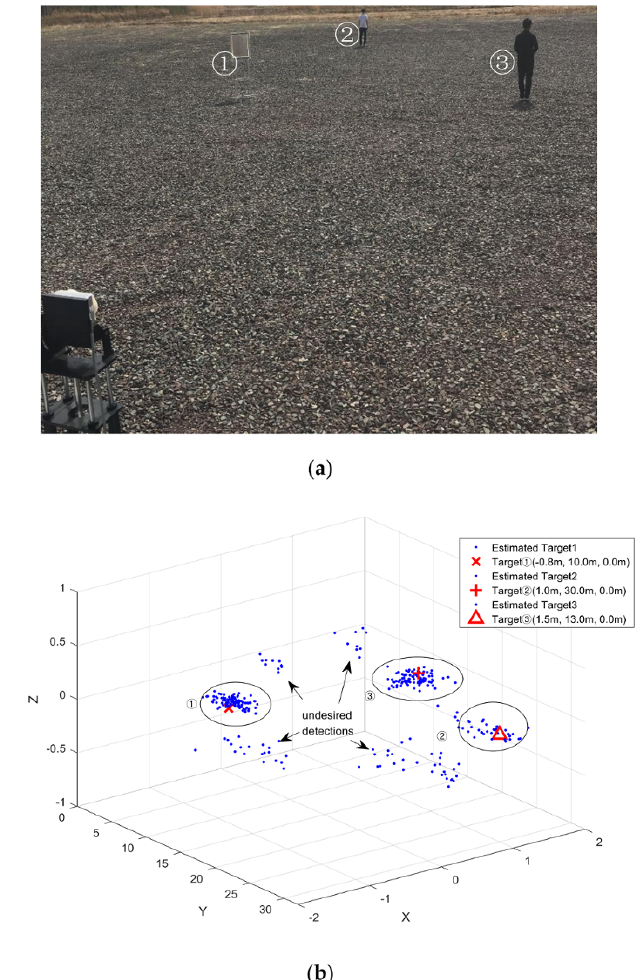
Figure 9. Detection results. ( a ) Outdoor experiment scenario; ( b ) detection